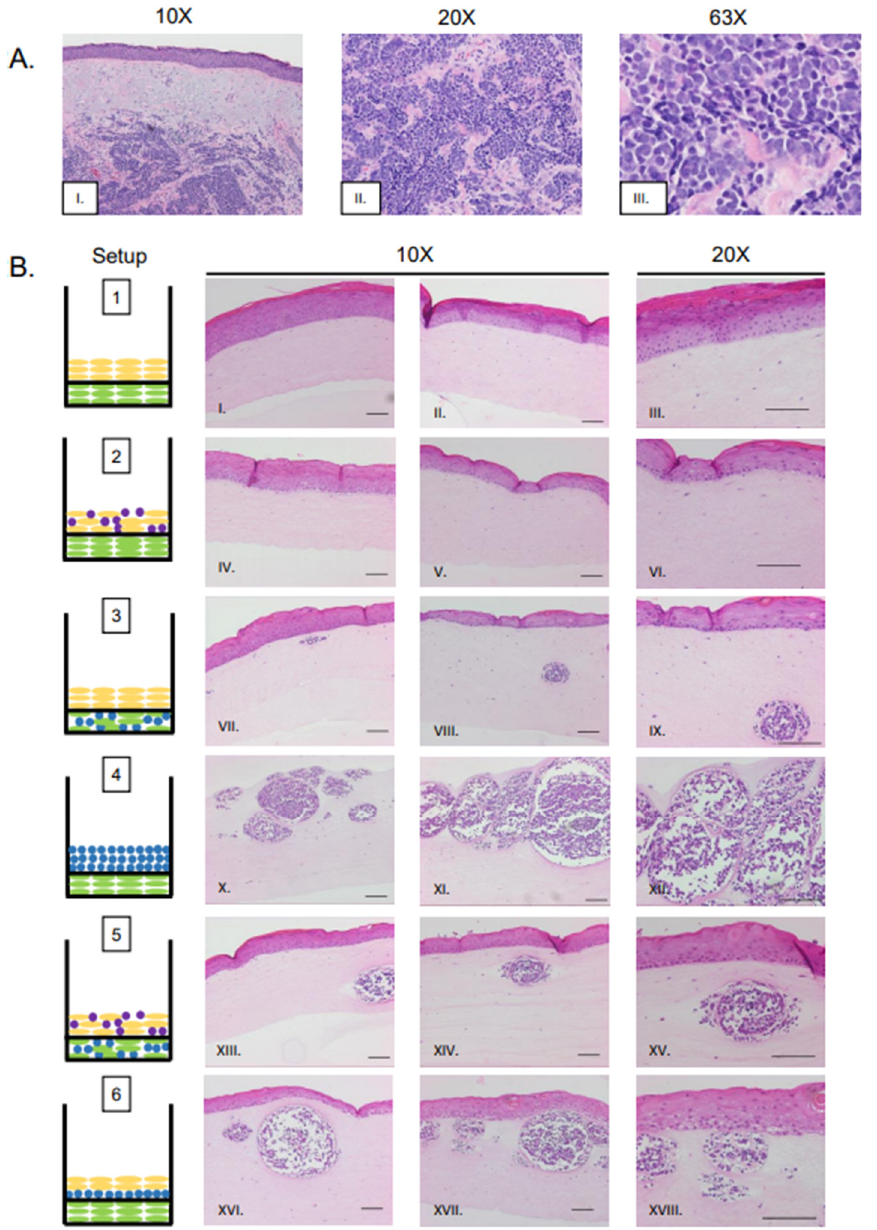
Figure 2. Histological analysis of MCPyV+ MCC-like lesions in organotypic raft cultures. ( A ) Representative images of H&E-stained tissue sections of human MCC tumors arising in the dermis of human skin (Panel I–III). ( B ) Representative H&E images of rafts generated using various culture conditions. Each raft setup is shown on the left and cell types are represented using the symbols outlined in Figure 1B. H&E-stained images are shown with 10 × magnification in the first two columns (one each of both replicate rafts) and 20 × magnification of histology in the rightmost column of one of those replicates (Panels I–XVIII). All scale bars = 100 µ